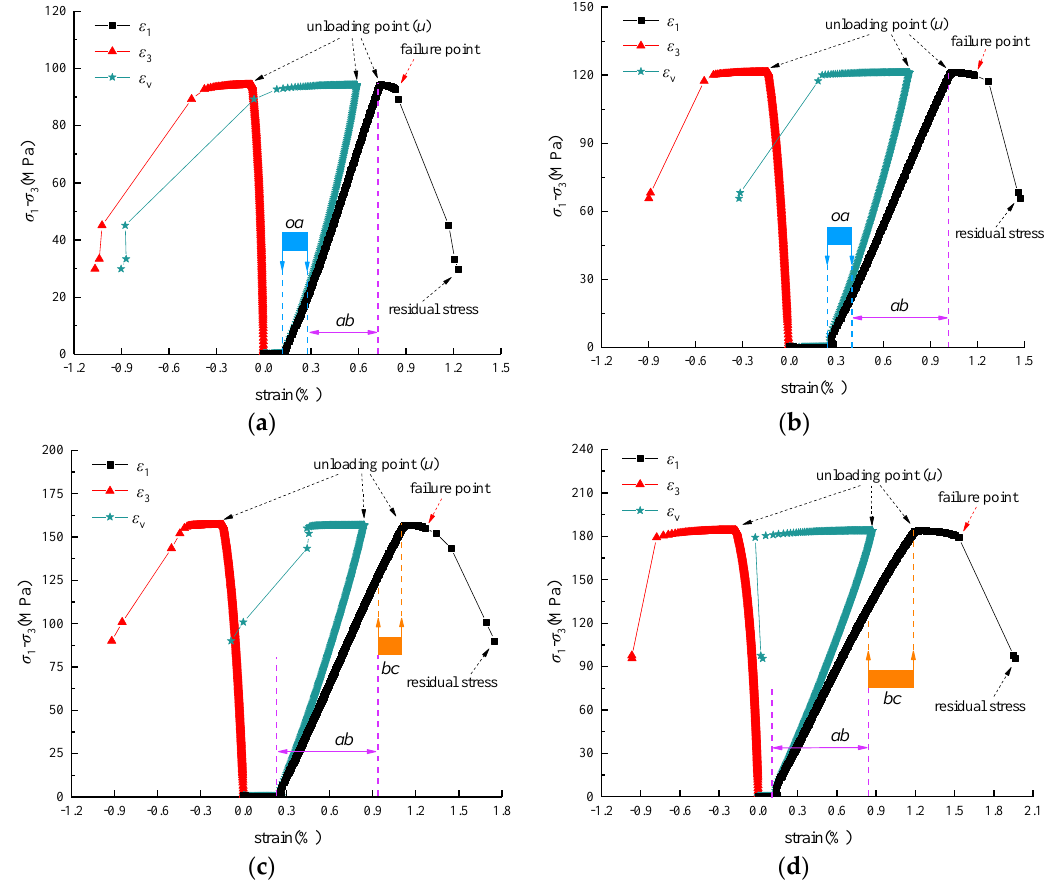
Figure 4. Stress-strain curves of sandstone unloading under different initial confining stresses. ( a ) σ 3 = 10 MPa; ( b ) σ 3 = 20 MPa; ( c ) σ 3 = 30 MPa; ( d ) σ 3 = 40 MPa. Table 1. Mechanical parameters of sandstone unloading